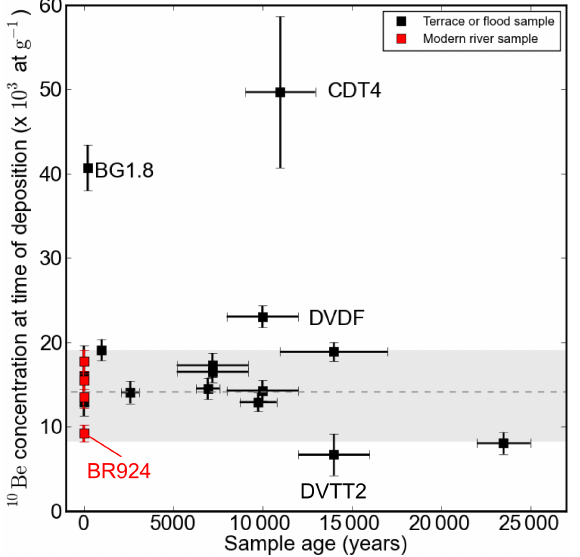
Figure 4. Measured modern river (red) and terrace or flood/floodplain (black) 10 Be concentrations relative to their depositional age. Horizontal error bars represent the published age error associated with the independently dated deposit, and vertical error bars represent error in 10 Be concentrations determined in this study. Sample BR924 from Lupker et al. (2012) is also included and labelled.